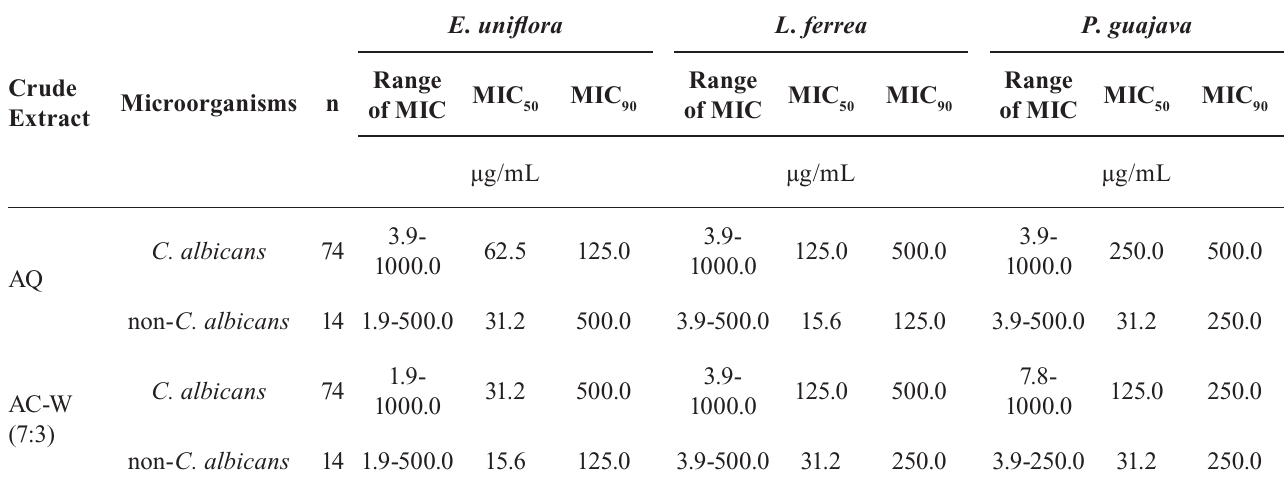
TABLE II - Antifungal activity of crude extracts against Candida albicans and non- C. albicans isolated from the oral cavity of kidney transplant